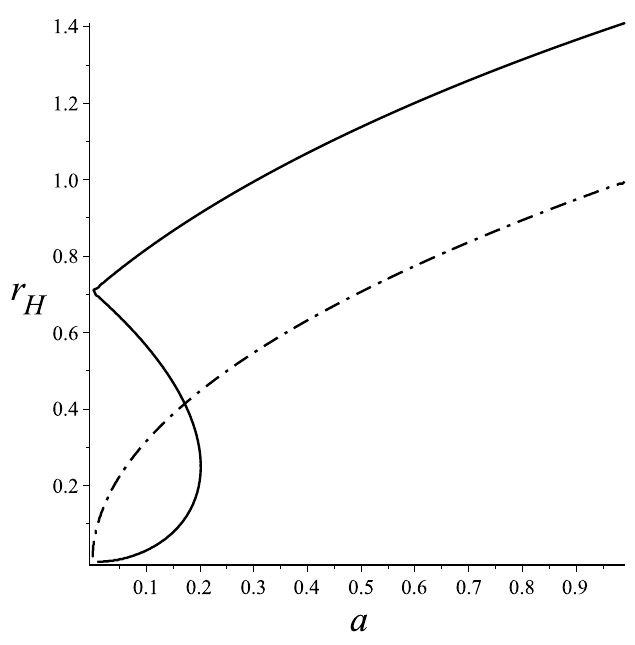
Figure 8 . AdS 5 -Kerr black holes are stable against superradiance for all pairs ( a, r H ) lying above the dotted-dashed curve. The other curves show the relation between a and r H for a black hole with temperature as small as possible in the non-rotating asymptotically AdS 5 case, with 0 j < 1 . L has been set equal to unity corresponding to 0 ≤